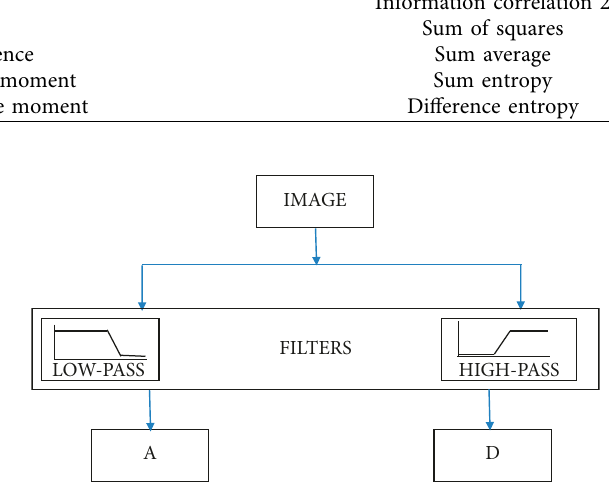
Figure 6: The discrete wavelet decomposition processing of an image into approximations and details